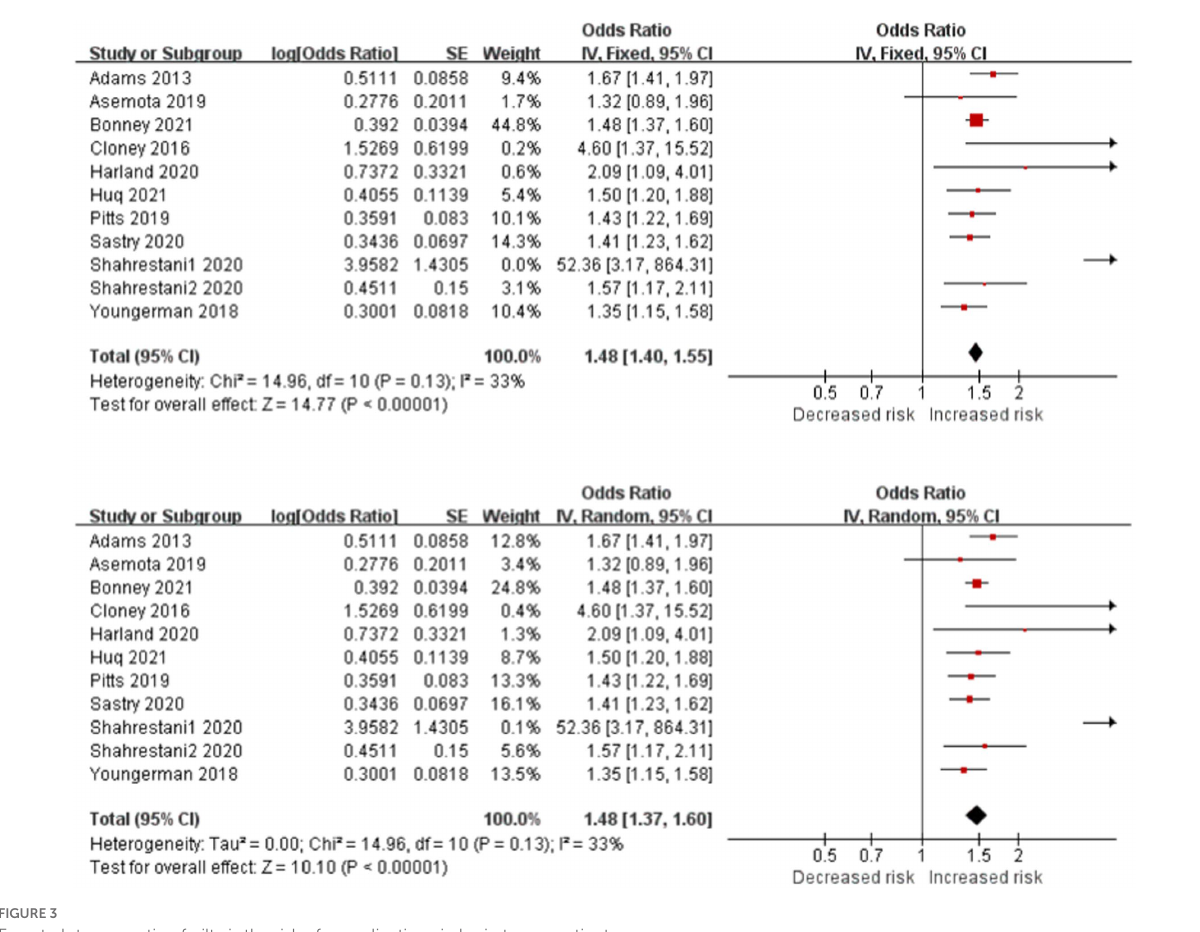
FIGURE 3 Forest plots presenting frailty is the risk of complications in brain tumor patients.